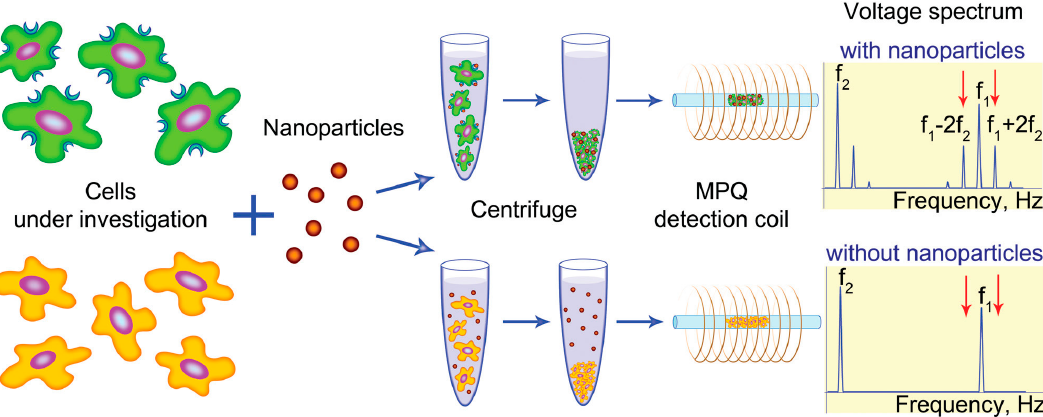
Figure 4. Schematic of the magnetic particle quantification (MPQ)-cytometry workflow. The investigated cells are incubated with the suspended nanoparticles. The unbound nanoparticles are then removed from the sample by centrifugation. The amount of nanoparticles bound to the cells is measured using the magnetic particle quantification (MPQ) technique at combinatorial frequencies (Reproduced with permission from [38]. The Royal Society of Chemistry, 2016.).